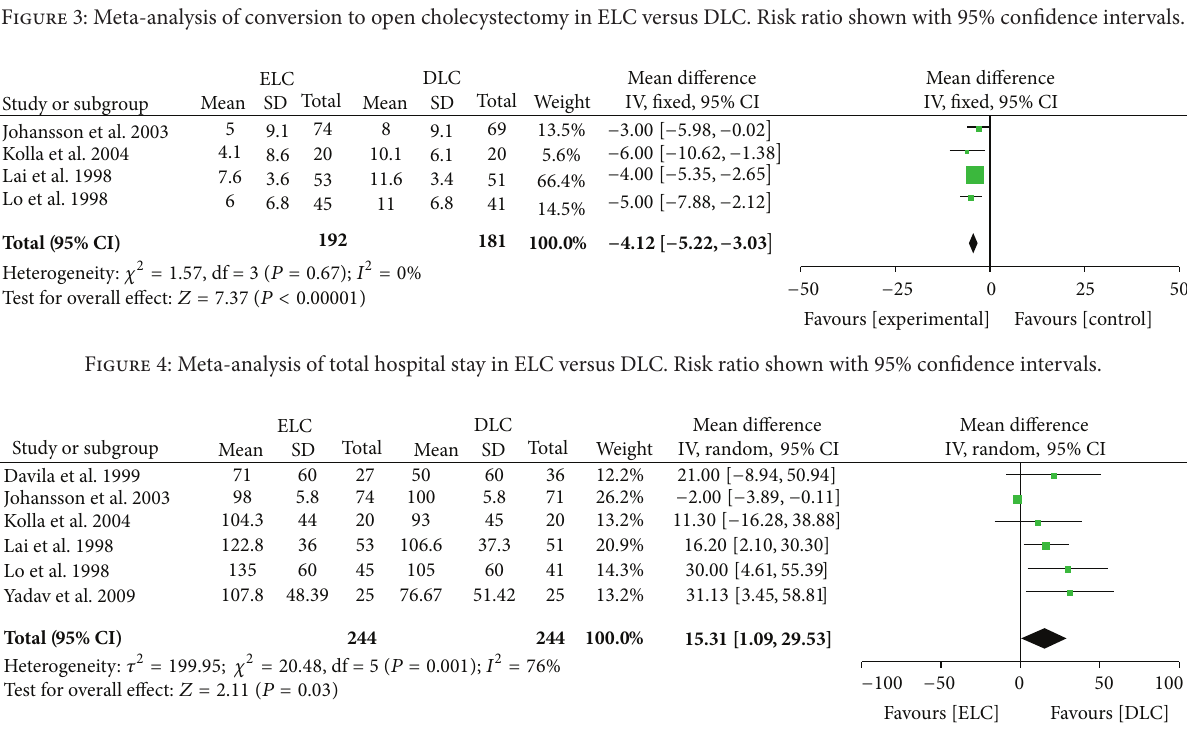
Figure 5: Meta-analysis of operation time in ELC versus DLC. Risk ratio shown with 95% confidence